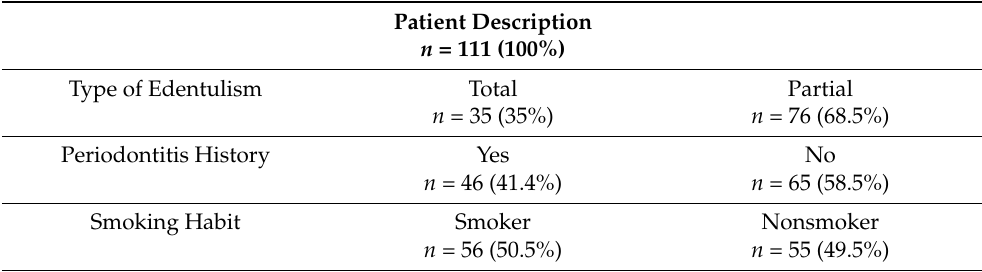
Table 1. Description of the sample distribution, according to the following parameters: type of edentulism, previous history of periodontitis, and smoking